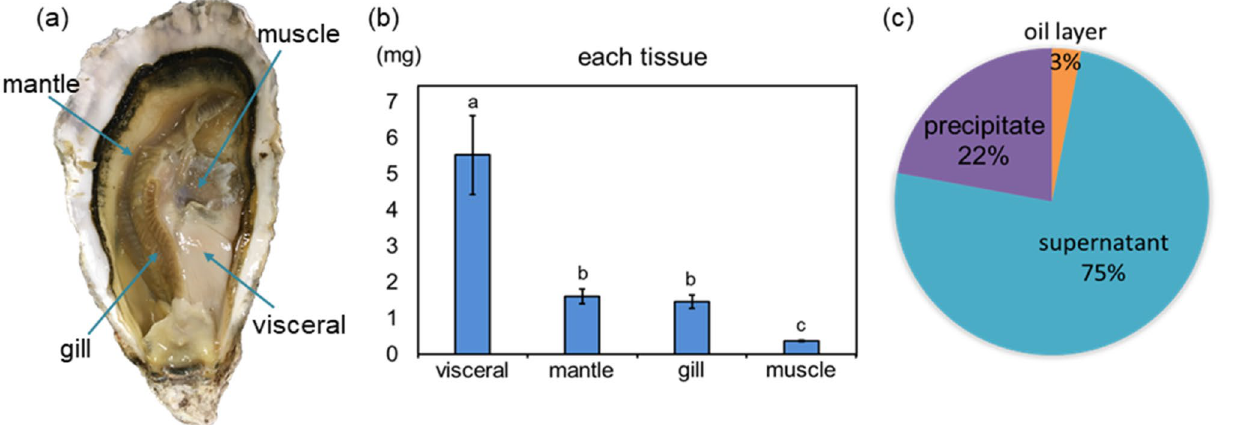
Figure 1. Distribution of Cd in each fraction of oyster viscera extract. ( a ) Four tissues, viscera, mantle, gills and muscle, were isolated from the dissected oysters. ( b ) The total mass of Cd contained in the visceral, mantle, gill and muscle tissues in an oyster. Error bars represent the standard deviation (n = 3); mean values with different lower-case letters (e.g., a – c ) are statistically different from one another (one-way analysis of variance, ρ < 0.05). The data was analyzed using IBM SPSS software (version 18.0; SPSS Inc.). ( c ) Fan-shaped distribution diagram of Cd mass percentage in each fraction of oyster viscera extract of oil layer, supernatant and